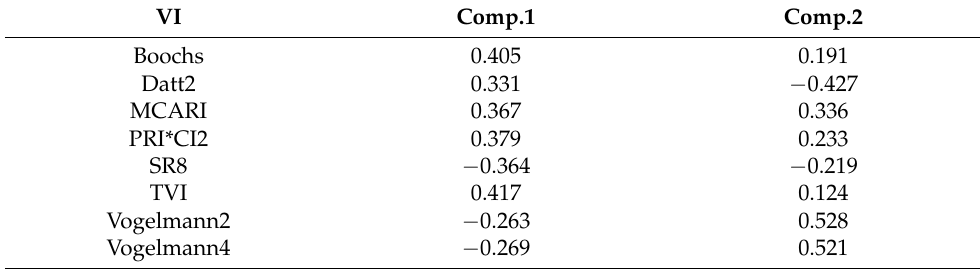
Table 8. VIs factor loadings on the main components for Ambrosia artemisiifolia , Atriplex tatarica , Glycyrrhiza glabra , Euphorbia seguieriana , and Setaria pumila .